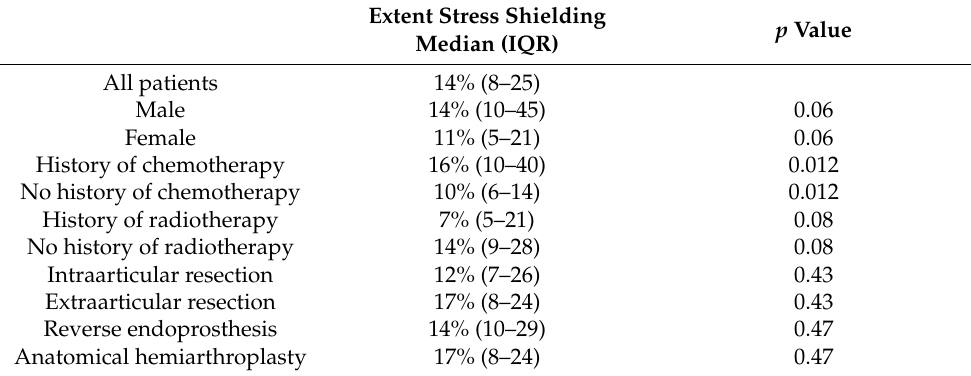
Table 2. Overview of the extent of stress shielding in different patient